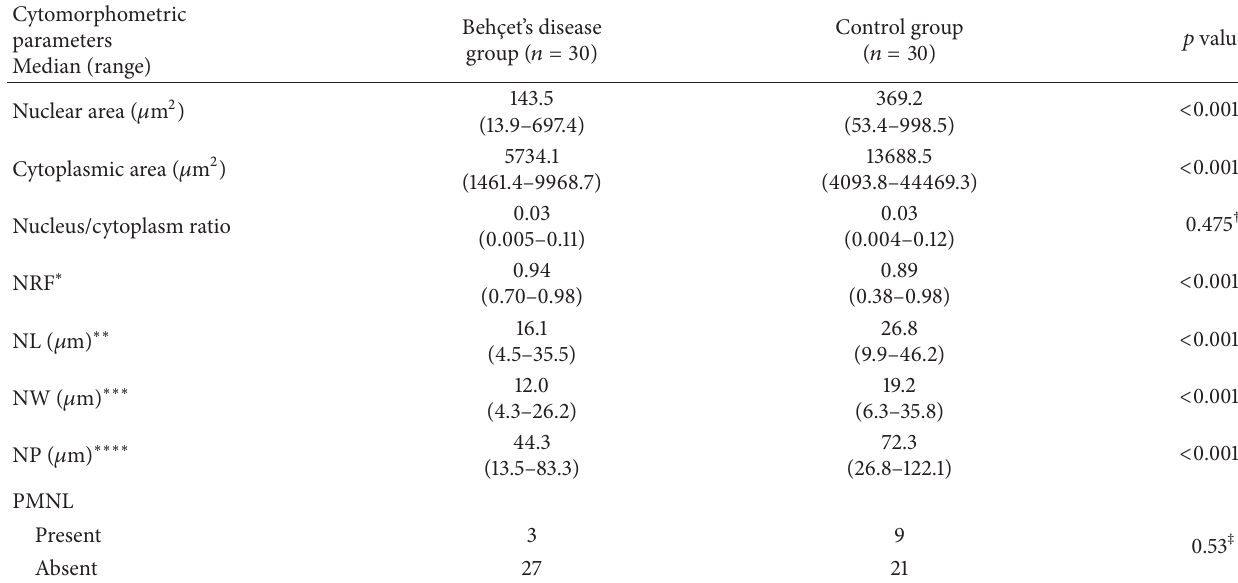
Table 2: Comparison of the cytomorphometric parameters and the presence of polymorphonuclear leukocytes (PMNL) in Behc¸et’s disease and control